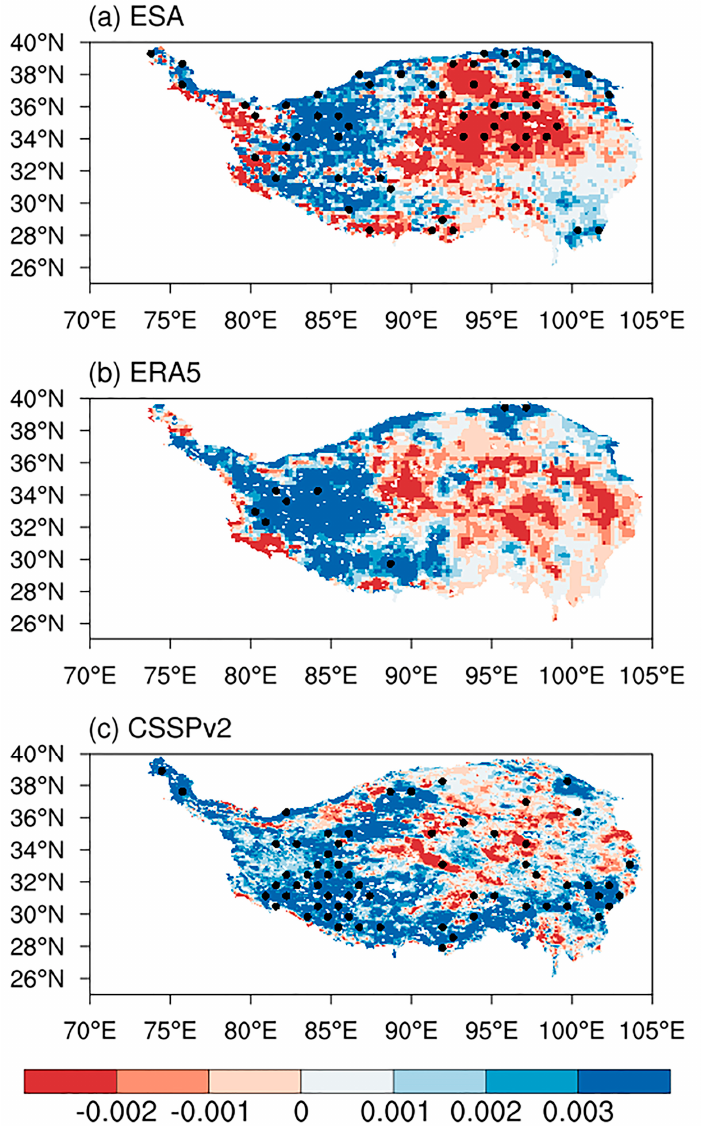
Figure 8. Spatial distributions of ( a ) ESA, ( b ) ERA5, and ( c ) CSSPv2 surface soil moisture trends from April to September of 2009 to 2017. The black dot indicates that it has passed the 95% signifi- cance test.